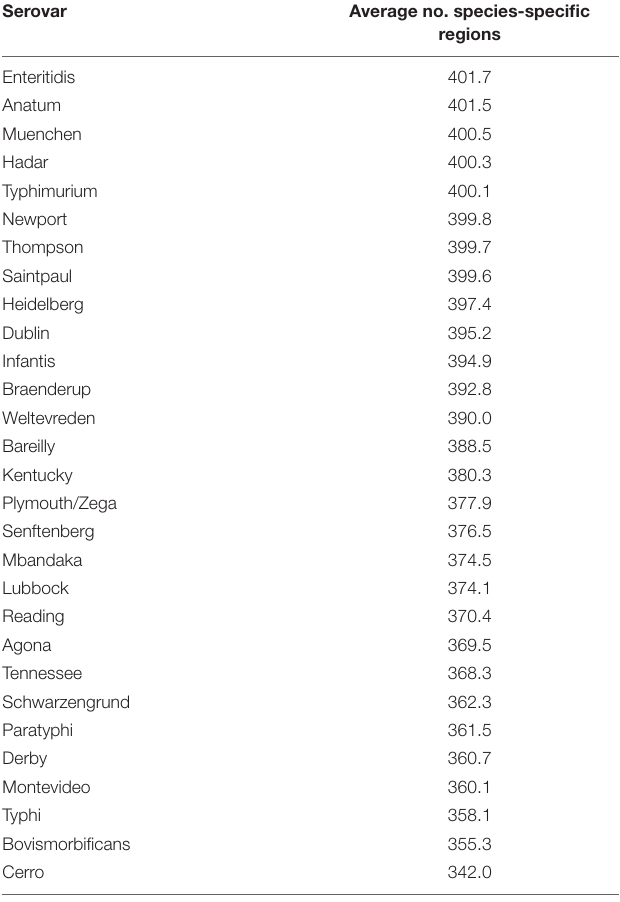
TABLE 3 | The average number of species-specific genomic regions found among serovars of subspecies enterica , that contained at least 10 representative genomes, within the 4870 quality filtered subspecies enterica genomes of this study.